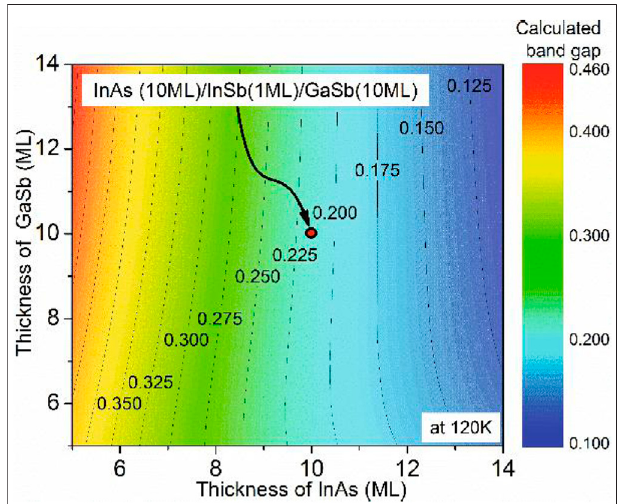
FIGURE3| Thecalculatedbandgapsusingthemodi fi edK · Pmodel.The x and y axes represent thenumber ofInAs andGaSbmonolayer,respectively. The calculated bandgap of 10 ML InAs/1 ML InSb/10 ML GaSb T2SL is 0.2 eV at 120 ° K. And as the thickness of InAs increases, while keeping the thickness of the GaSb layer constant, the cut-off wavelength of the InAs/ GaSb T2SL also